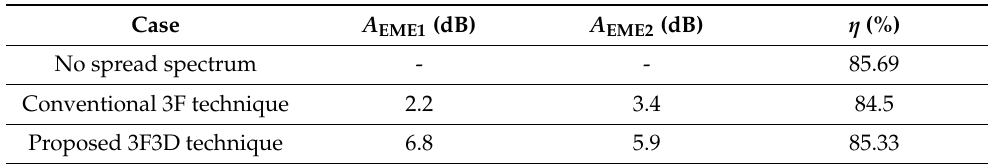
Table 2. The first and the second harmonic amplitude reduction coefficients ( A EME1 and A EME2 ) and the efficiencies ( η ) for different cases. Case No spread spectrum Conventional 3F